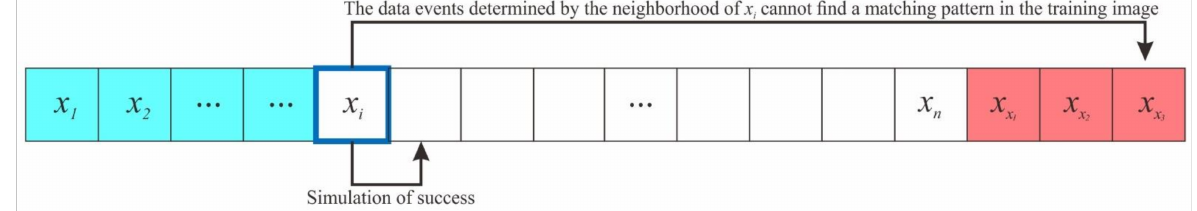
Figure 1. Simulation path of the dynamic